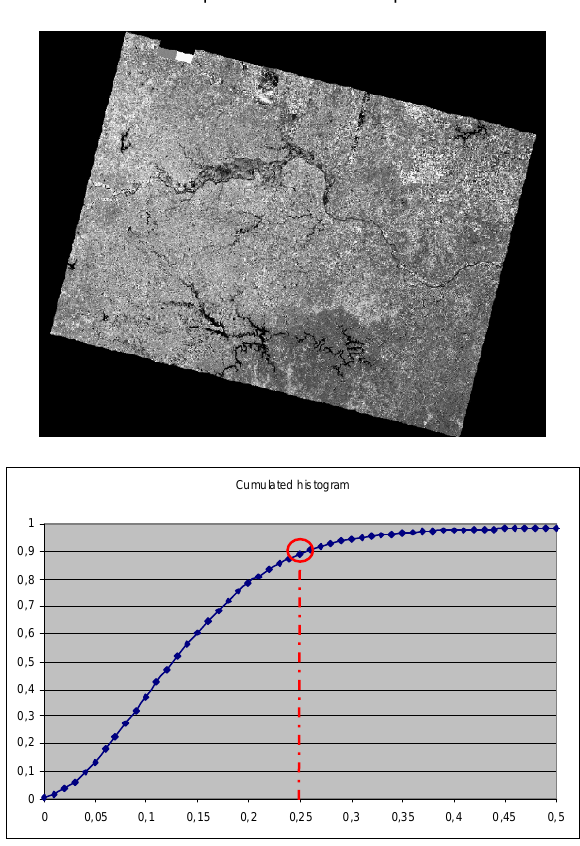
Figure 10: Level-1C Ortho-image and cumulative histogram on registration residuals (in